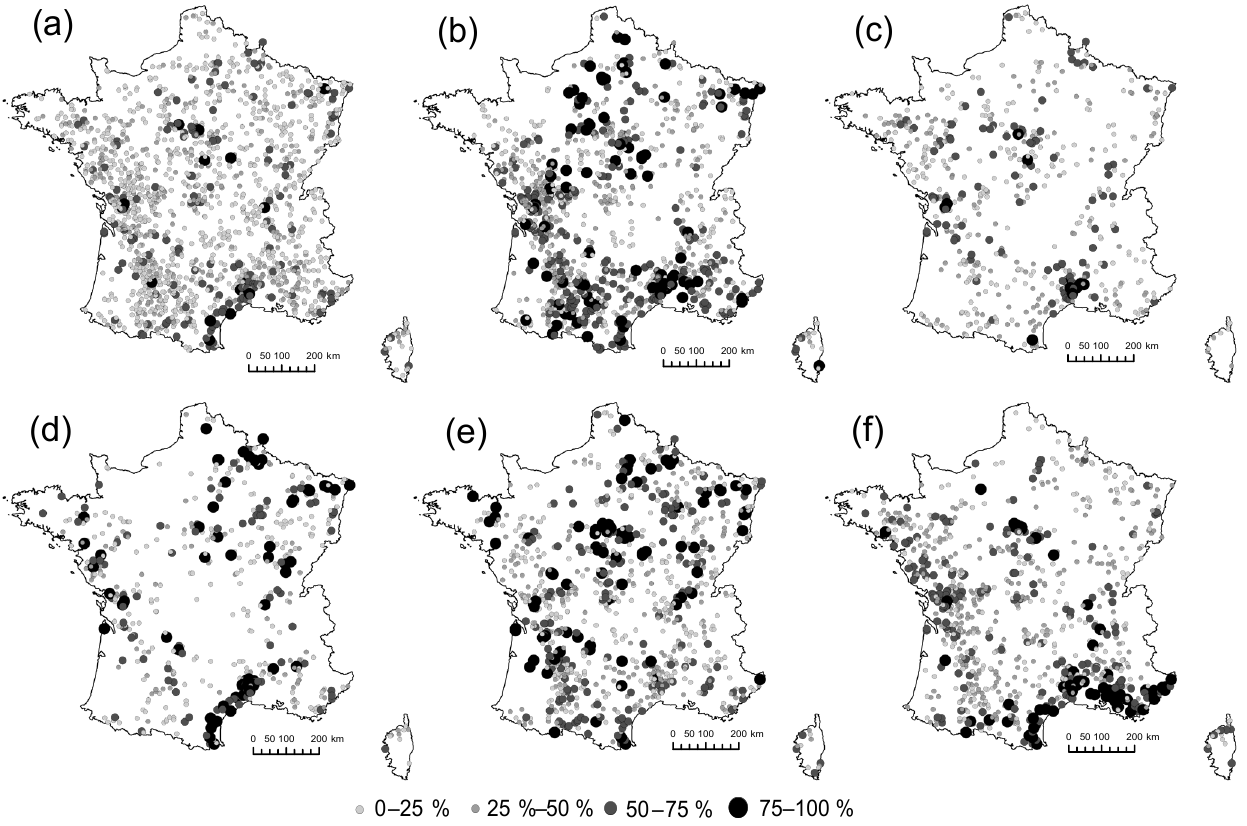
Figure 5. Distribution of the percentages of drying observed at ONDE sites for the years (a) 2012–2016, (b) 2012, (c) 2013, (d) 2014, (e) 2015 and (f) 2016.